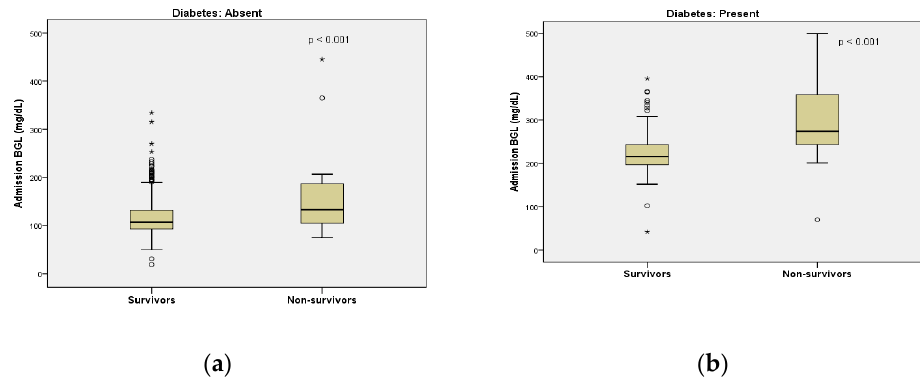
Figure 2. Box plot demonstrating the effect of admission blood glucose levels on mortality in pa- tients without diabetes mellitus ( a ) and in patients with diabetes ( b ). Values are median and interquartile range; dots (°) represent outliers; * represent extreme values (shows non-normal distribution).